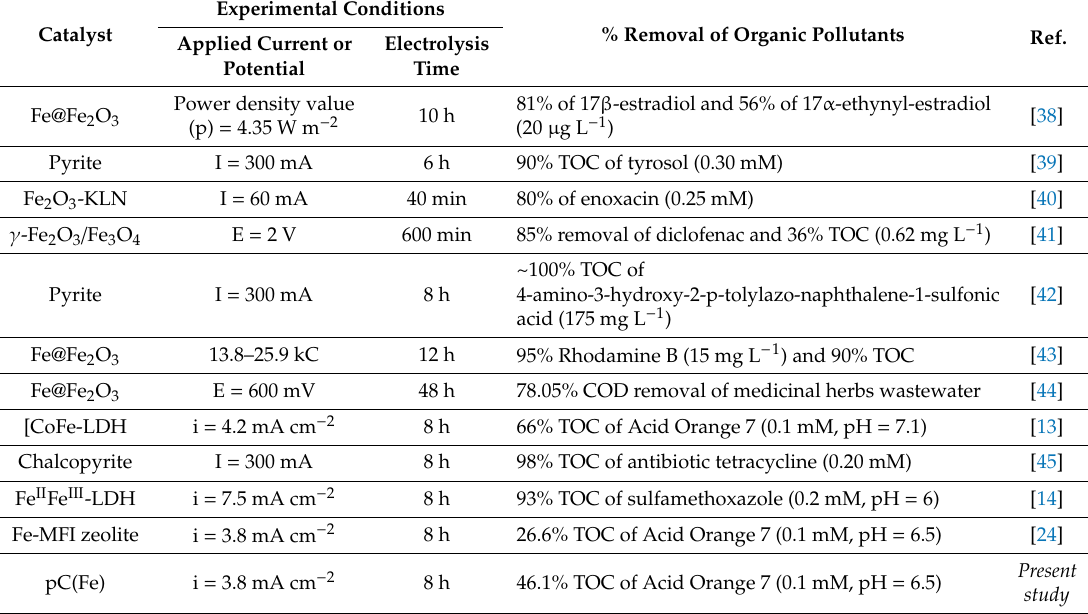
Table 4. Summary of catats for heterogeneous EF process using CF